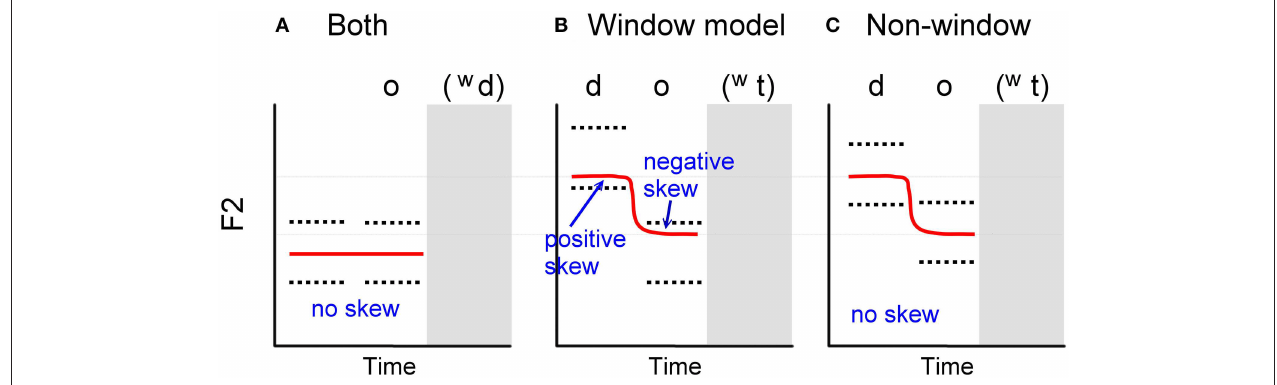
FIGURE 1 | Predictions of skewness in the F2 distributions. Red solid lines are the predicted central tendency of F2 trajectories. Black dotted lines are the hypothesized target ranges. (A) Prediction by both the window model and non-window hypothesis for /o w d/. (B) Prediction by the window model for /do w t/. (C) Prediction by non-window hypothesis for /do w t/ from the onset to the end of /o/. The offglide /w/ and the stop coda parts are